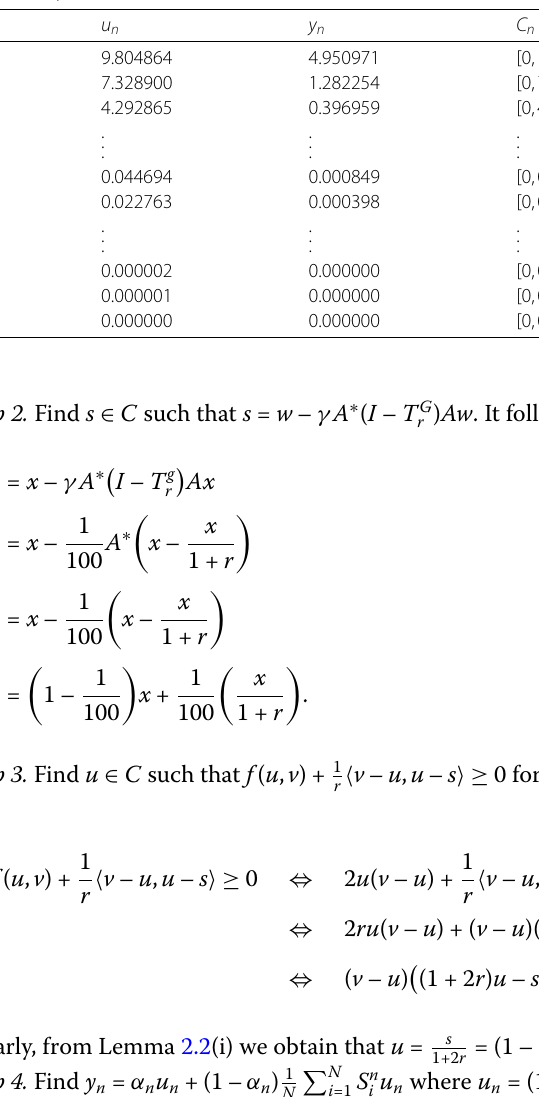
Table 1 Numerical results of Example 3.2 with α n = 0.5 and initial guess x 1 = 10. α n = 0.5 and x 1 = 10 n u